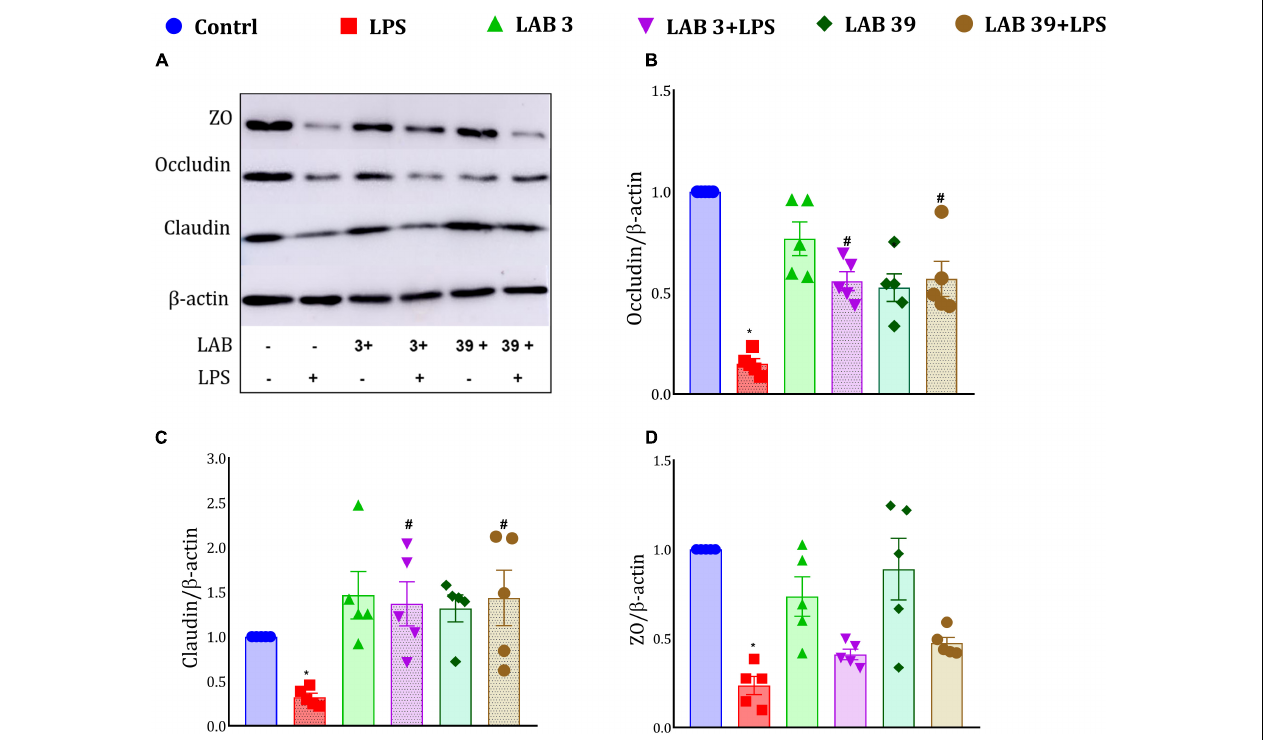
FIGURE 9 | Effect of LAB on the tight junction protein expression: (A) Representative Western blotting images; (B) expression of occludin relative to β -actin; (C) expression of claudin relative to β -actin; and (D) expression of zona occludin relative to β -actin. Data were analyzed using one-way ANOVA with Tukey’s post hoc test ( p ≤ 0.05). *Significant relative to control; #significant relative to the LPS group ( N =